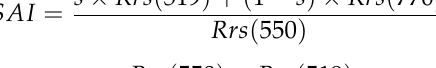
(Table 2). Since the bands of the GF-4 satellite are different from the corresponding bands